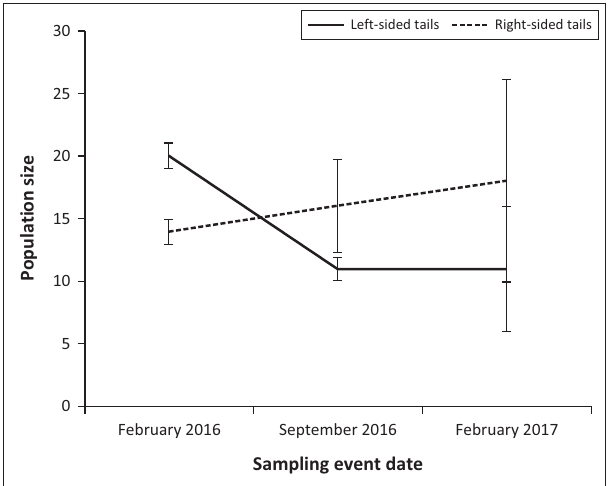
FIGURE 3: Modelled crocodile abundance across three repeat sampling events at Sunset Dam, Lower Sabie, Kruger National Park, using a Cormack-Jolly-Seber mark-recapture analysis. See text for model